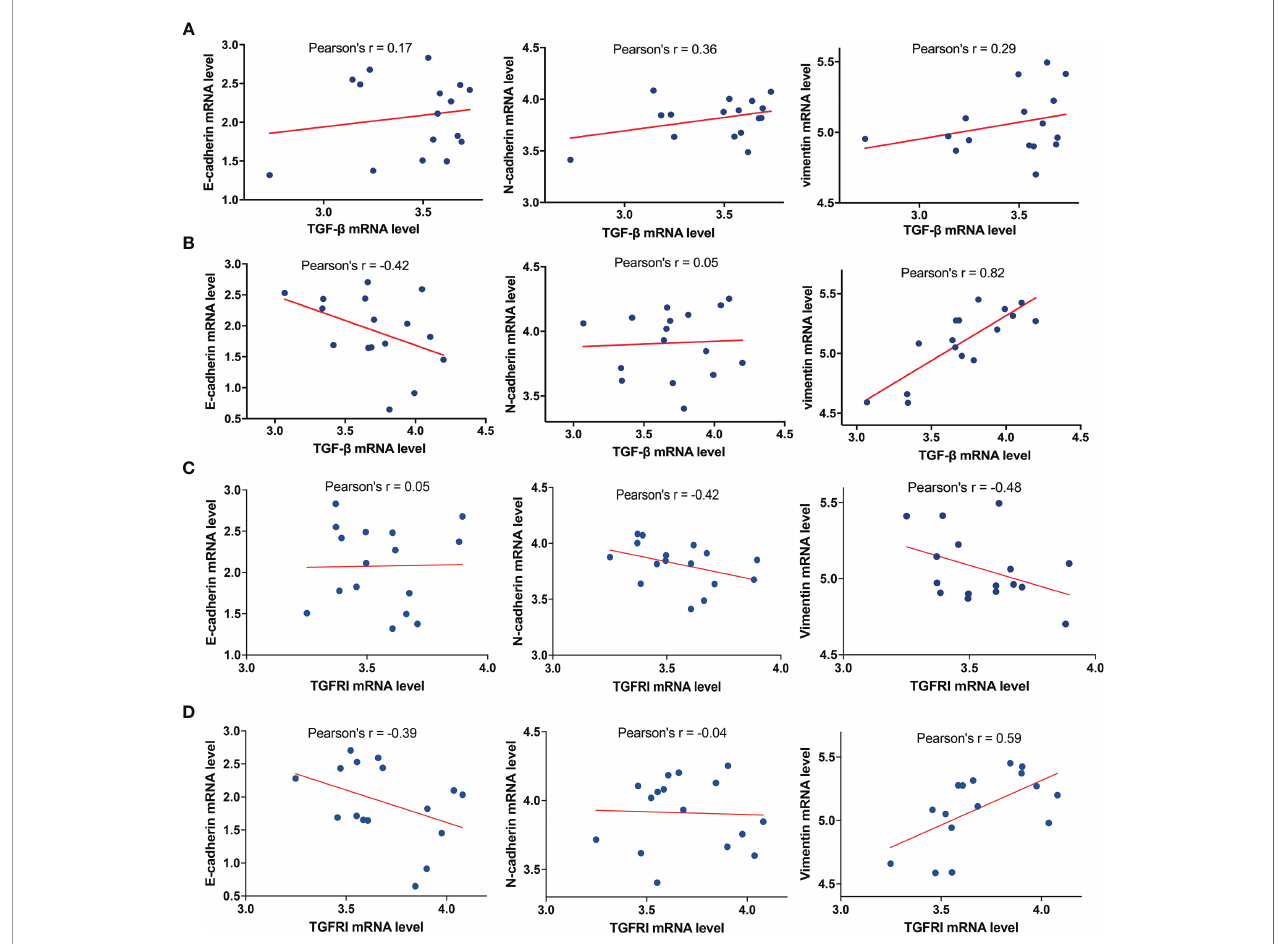
FIGURE 6 | MICAL2 promotes EMT-like of glioma cells through TGFRI/p-Smad2 signaling pathway. (A, B) Correlation of TGF- b expression with E-cadherin, N-cadherin, and vimentin in the low MICAL2 expression group and high MICAL2 expression group. (C, D) Correlation of TGFRI expression with E-cadherin, N-cadherin, and vimentin in the low MICAL2 expression group and high MICAL2 expression